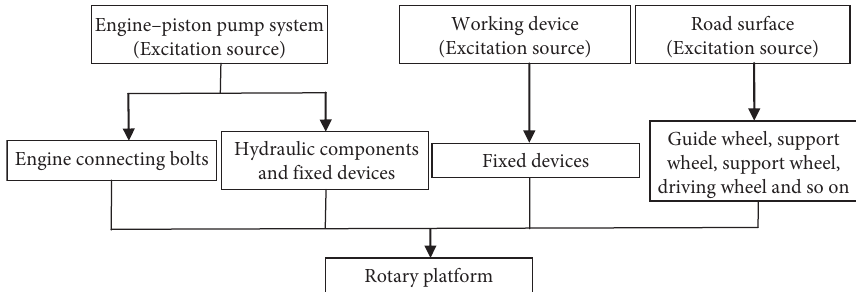
Figure 2: Vibration transmission paths of the rotary platform of hydraulic excavator.